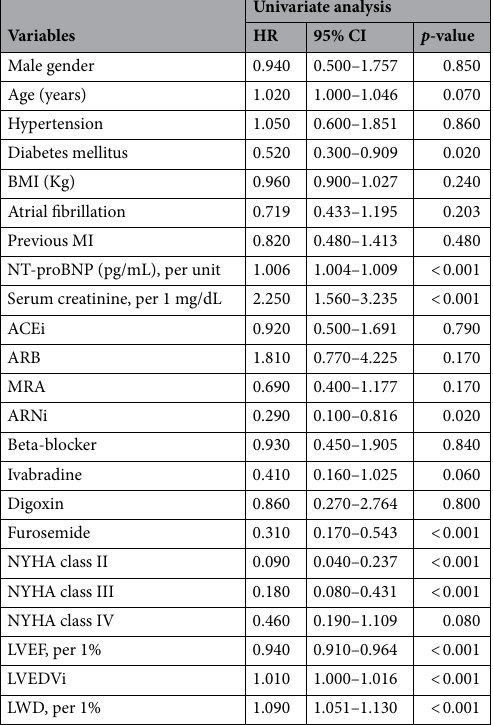
Table 2. Univariate Cox regression model for the primary composite endpoint. ACEi angiotensin-converting enzyme inhibitor, ARB angiotensin II receptor blocker, ARNi angiotensin receptor-neprilysin inhibitor, BMI body mass index, CI confidence interval, HR hazard ratio, LVEDVi left ventricle end-diastolic volume index, LVEF left ventricular ejection fraction, LWD lung water density (%), MI myocardial infarction, MRA mineralocorticoid receptor antagonist, NYHA New York Heart Association.